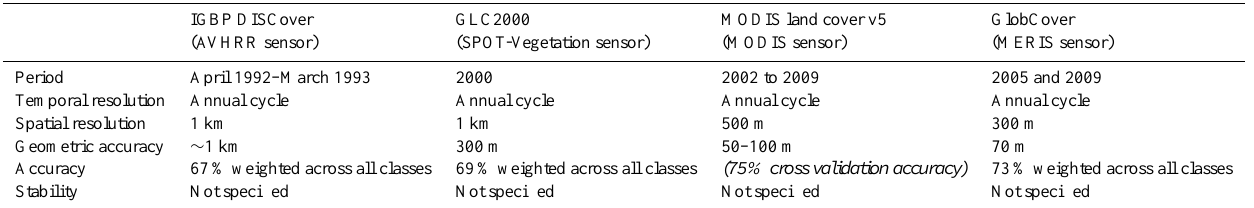
Table 3. Capabilities of four global land cover products currently used by the climate modeling